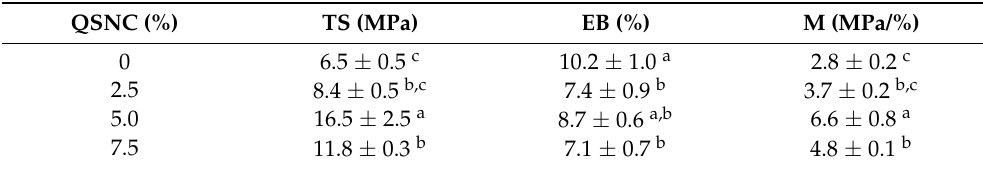
Table 2. Cassava film mechanical properties with quinoa starch nanocrystals (QSNC) at different concentrations